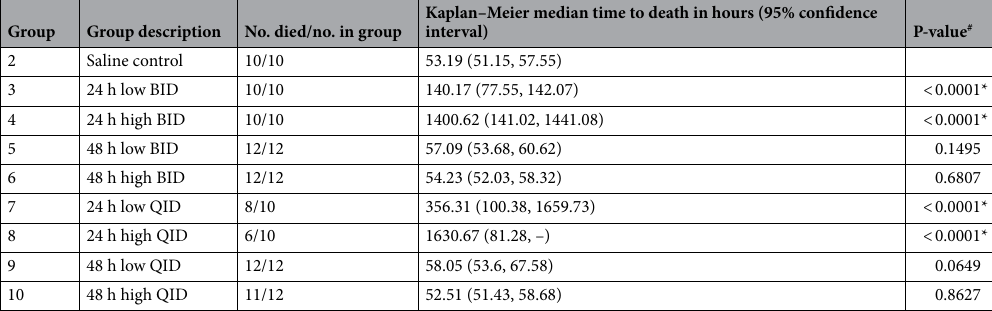
Table 3. Kaplan–Meier median times to death with 95% confidence intervals and P-values from log rank tests comparing times to death between each of the treated groups and the vehicle group. The median time to death of the control group and each treated group and the statistical comparison of the treated groups to the control group. Times to death of the four 48 h post-exposure treatment initiation groups were not significantly different from the control group, indicating that 48 h is too late to therapeutically intervene at the targeted exposure dose. Times to death of the four 24 h post-exposure treatment initiation groups were significantly greater than the control group. – Upper confidence bound could not be estimated due to large number of surviving animals. # P-value is for log rank test comparing survival rates between the treated group and the saline control group. Overall error rate of the eight tests is controlled at 5% using the Bonferroni-Holm multiple comparison procedure. *Time to death of the treated group is significantly greater than that of the control